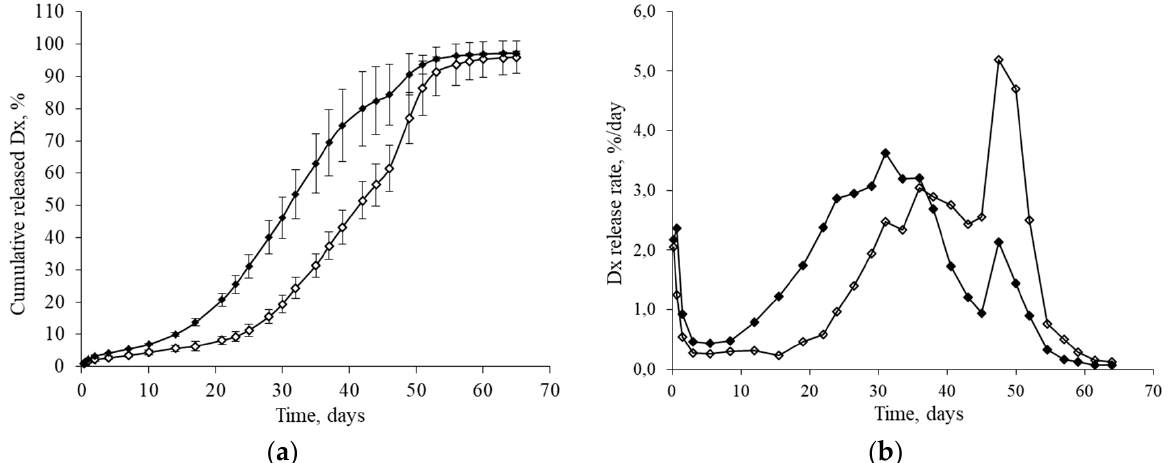
Figure 5. Release profile of dexamethasone from non-sterilized ( ◊ ) and sterilized ( ♦) PLGA microspheres (53–20 µm, prepared at 9,500 rpm). ( a ) Cumulative release (%) and ( b ) release rate (%/day). Data points (± standard deviations) ( n = 10).